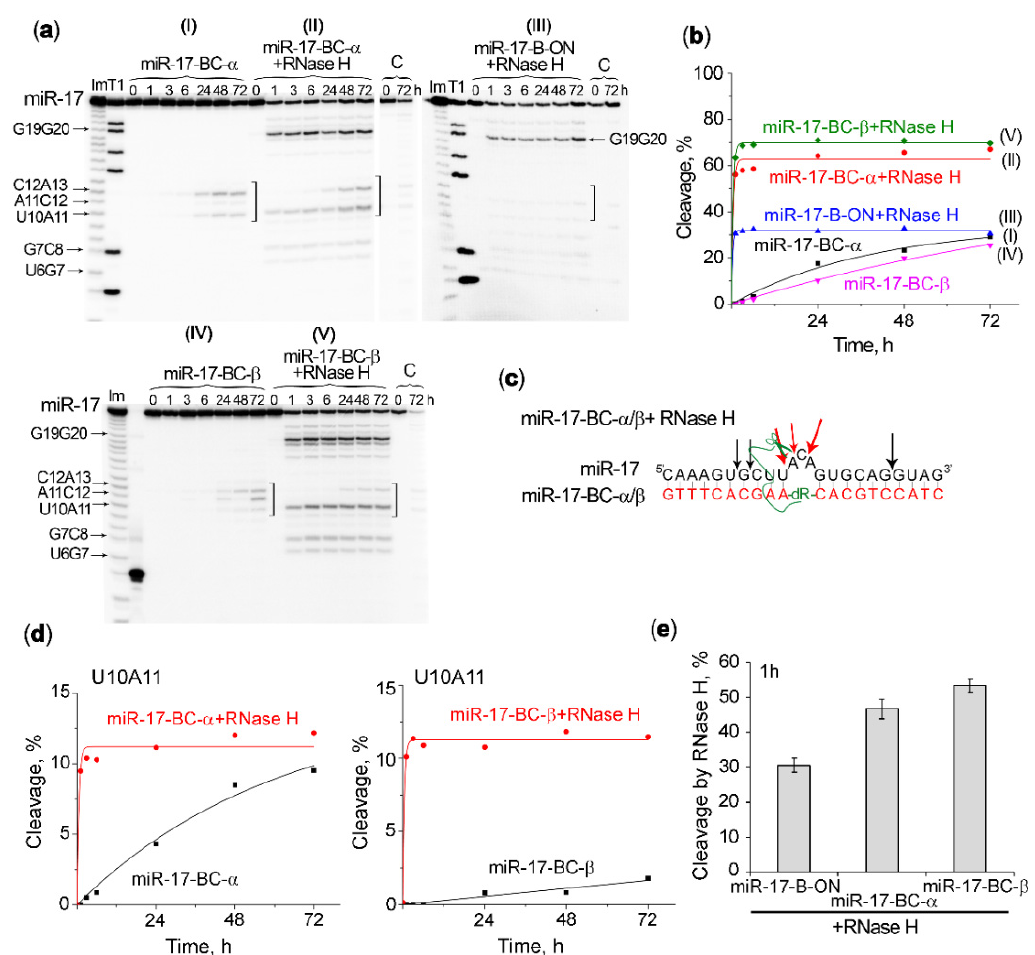
Figure 5. Cleavage of 5 (cid:48) -[ 32 P]-miR-17 by miR-17–BC- α , miR-17–BC- β , and/or RNase H. ( a ) Radioautographs of 18% denaturing PAAG showing the profiles of miR-17 cleavage by miR-17–BC- α alone (I), by a combination of miR-17–BC- α and RNase H (II), by RNase H in a complex with the oligonucleotide miR-17–B-ON (III), by miR-17–BC- β alone (IV), or by a combination of miR-17–BC- β and RNase H (V). Duplexes formed between 5 (cid:48) -[ 32 P]-miRNA (1 µ M) and BC or B-ON (20 µ M) were incubated in Buffer 2 at 37 ◦ C for 72 h. RNase H was used at a concentration of 5 u/mL. Lanes Im and T1: imidazole ladder and partial RNA digestion with RNase T1, respectively; C: control, RNA was incubated in the same buffer in the absence of BC or B-ON and in the presence of RNase H. The incubation time is shown at the top. The square bracket indicates the bulge-loop region. ( b ) Progress curves of miR-17 cleavage by BCs and/or RNase H. ( c ) The major positions of miR-17 cleavage by BC (red arrows) and RNase H (black arrows) when acting jointly. ( d ) Progress curves of miR-17